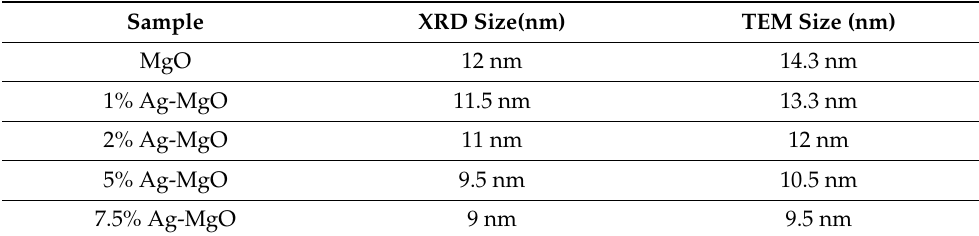
Table 1. Structure characterization of pure and Ag ‐ MgO NPs.